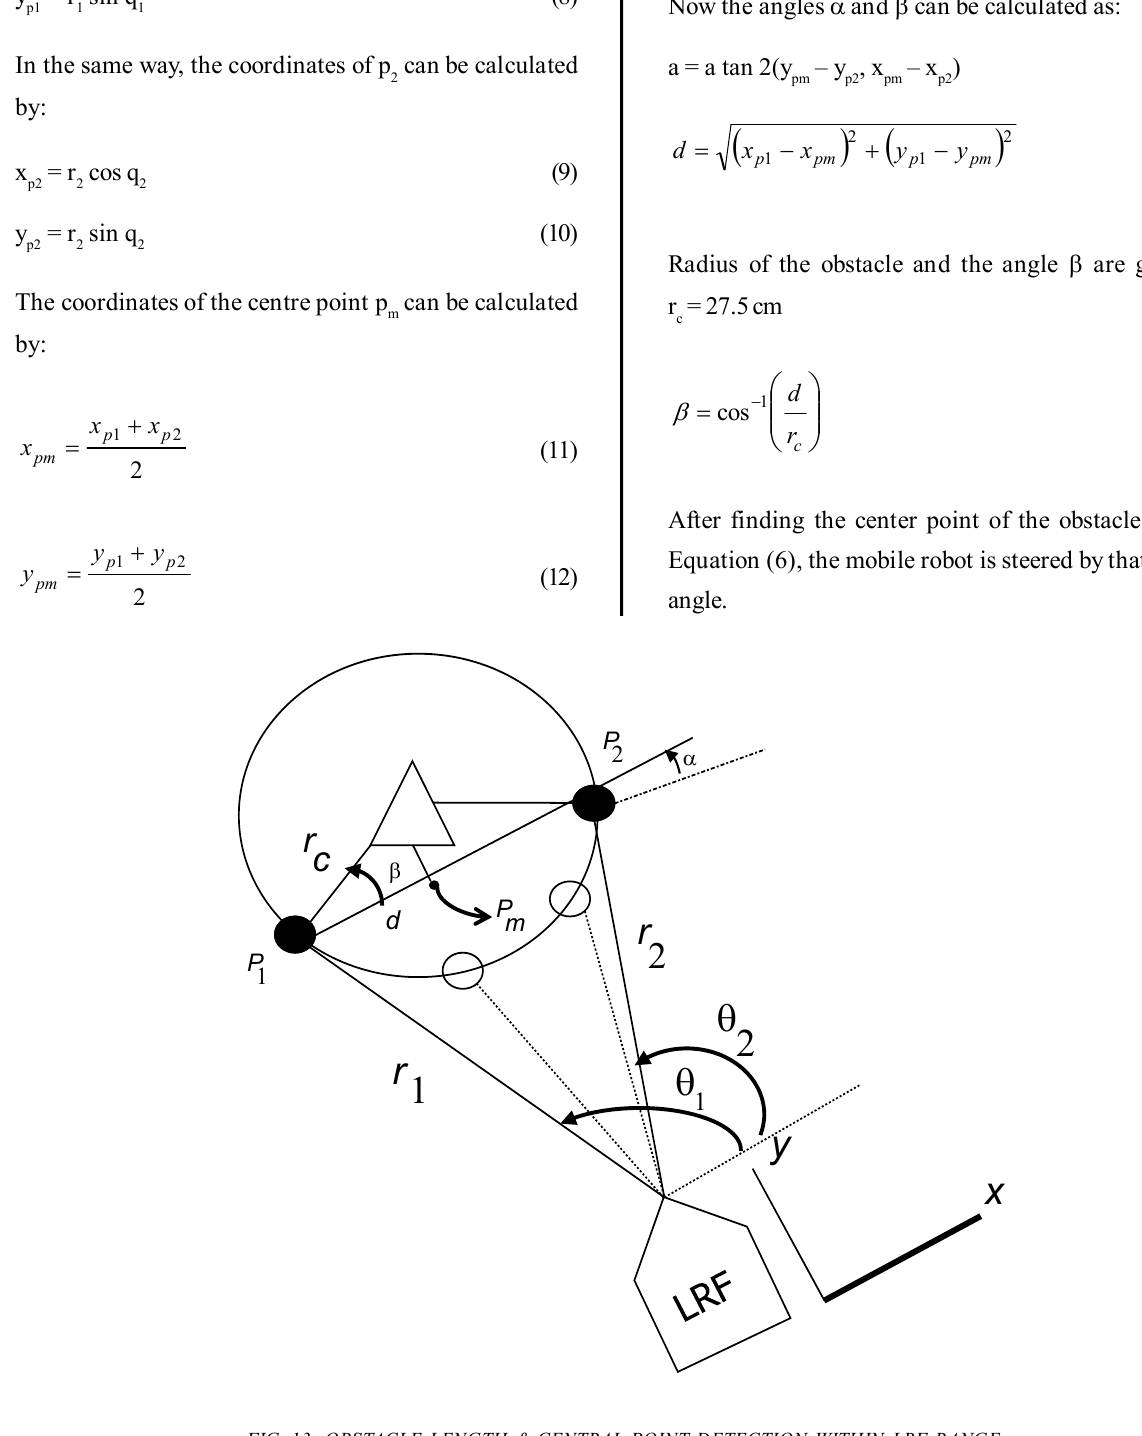
FIG. 13. OBSTACLE LENGTH & CENTRAL POINT DETECTION WITHIN LRF